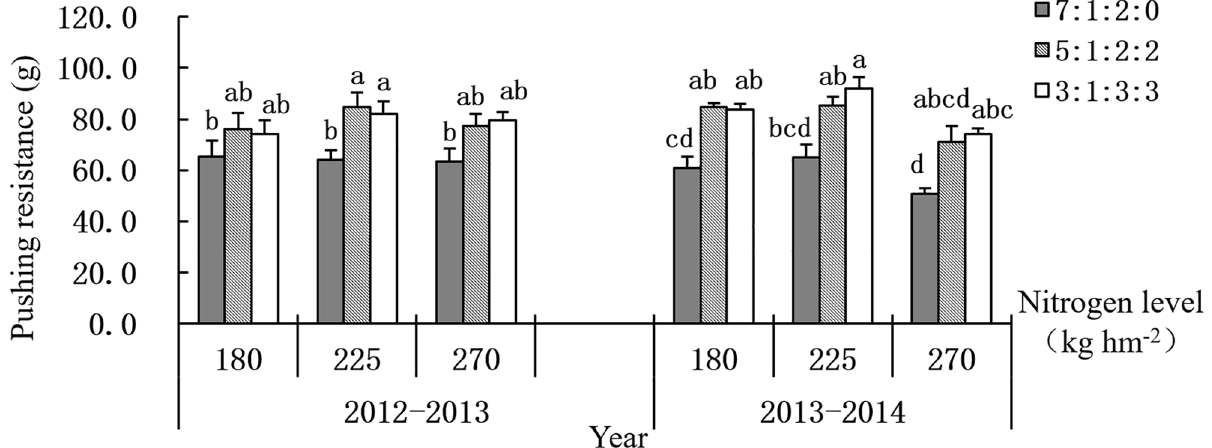
Fig 2. Effect of nitrogen levels and ratios on pushing resistance. Different letters on the culm mean significantdifference among the treatments at P < 0.05 as determined by the LSD test. The test was conductedseparatelybetweenthe two years.